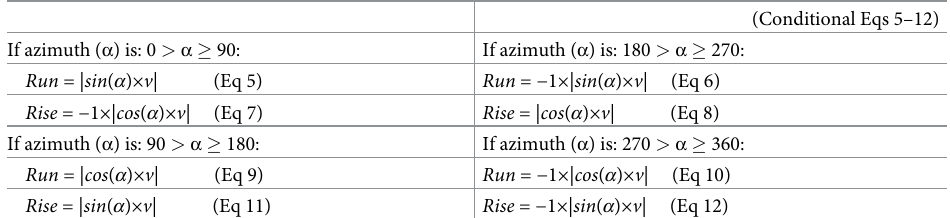
Table 2. Azimuth and altitude angles conformed to a Cartesian coordinate